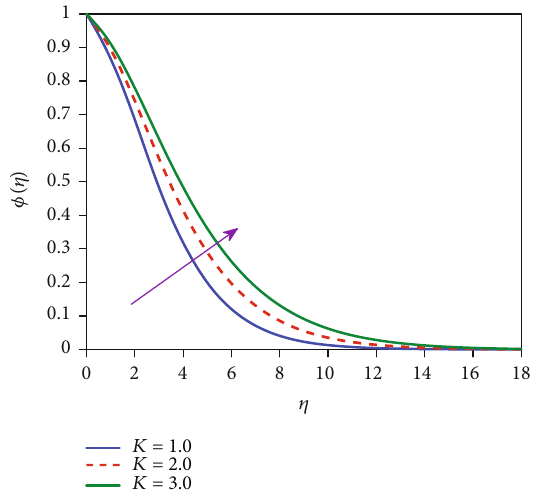
Figure 23: E ff ect of K on the secondary velocity g ð η Þ .